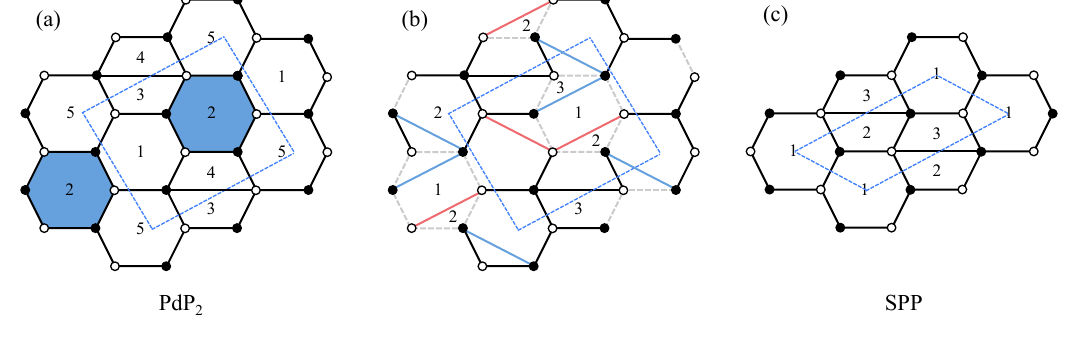
Figure 48. Instanton backreaction from PdP 2 to SPP.